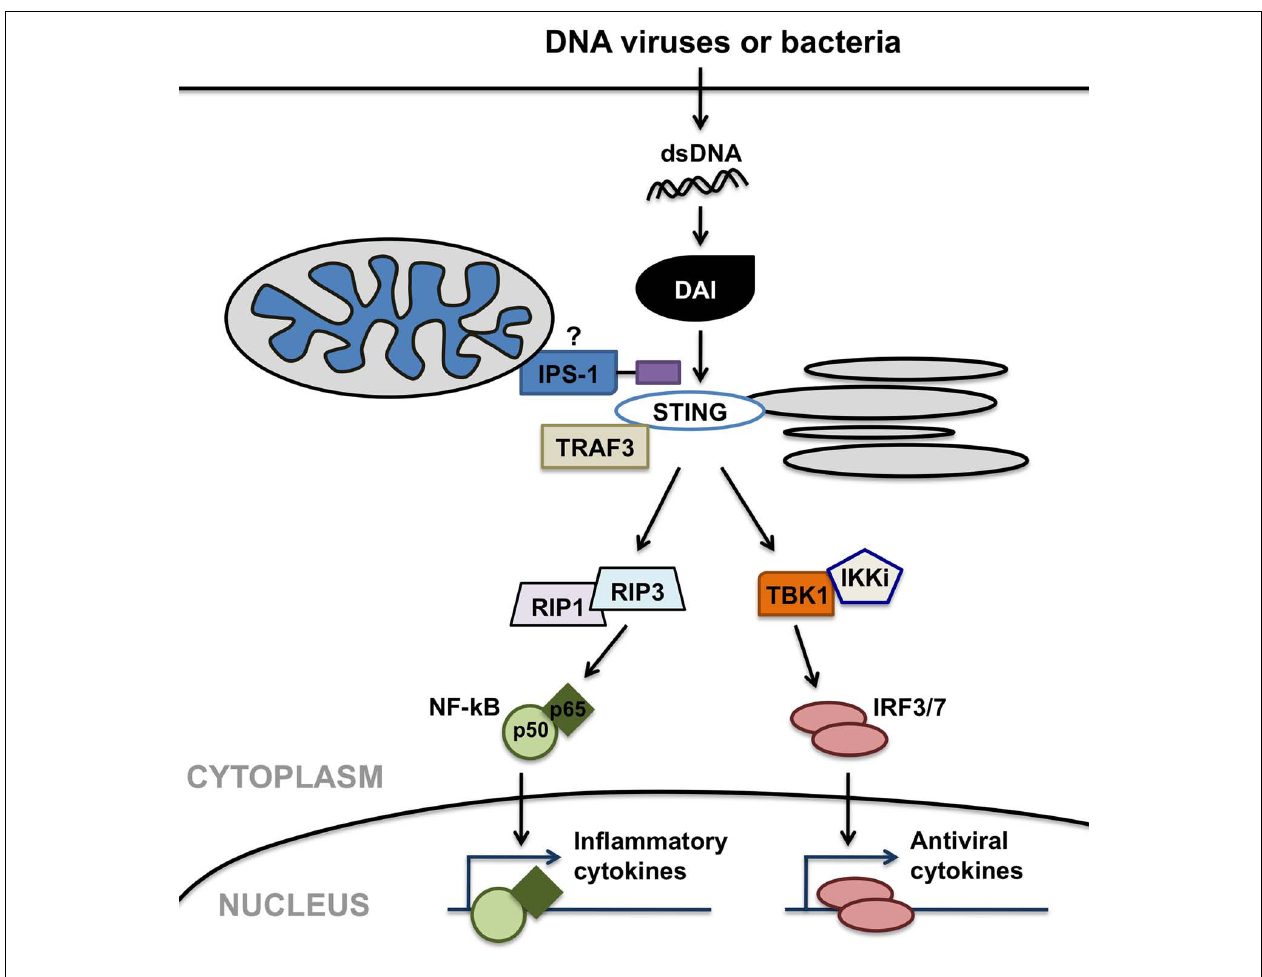
(IPS)-1, and/or stimulator of interferon genes (STING), facilitating the activation of the interferon-regulatory factors (IRF) and NF- κ B transcription factors. DAI-induced IRF activation is dependent onTANK-binding kinase 1 (TBK1). In contrast, DAI-induced NF- κ B activation is mediated through interactions involving receptor-interacting protein (RIP) 1 and RIP3